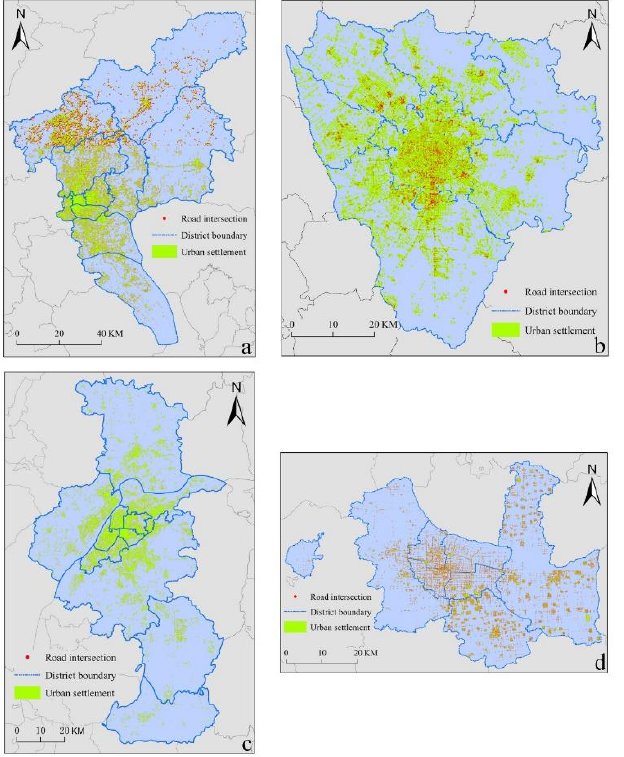
Figure 8. Urban settlements of Guangzhou ( a ), Chengdu ( b ), Nanjing ( c ), and Shijiazhuang ( d ).